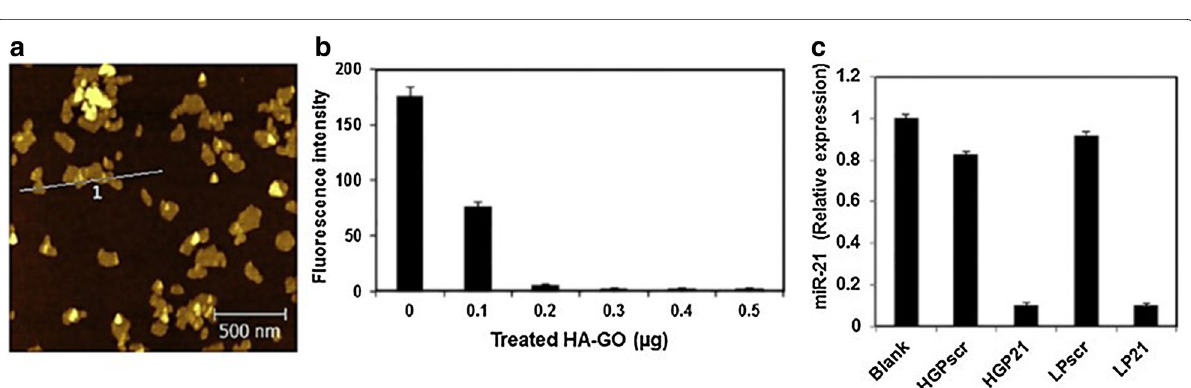
Fig. 7 a AFM image of synthesized HA-GO (hyaluronic acid–graphene oxide complex) and fluorescence measurement to confirm b loading of PNA and c targeted miR-21 knockdown. HG HA-GO, L lipofectamine 2000, P 21 PNA for miR-21, P scr PNA scrambl (Reproduced with permission